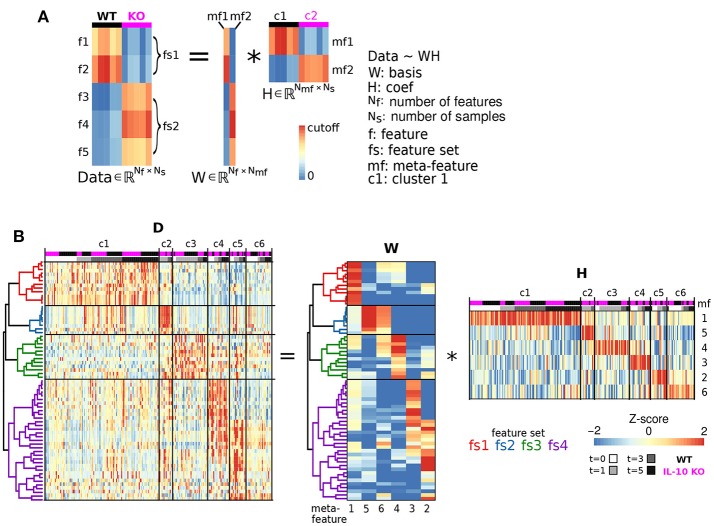
Morphological cell states characterized by distinct sets of morphological features. (A) Illustrative example of Non-negative matrix factorization (NMF) to show representations of a Data matrix, Basis matrix, and Coefficient matrix. (B) Microglial morphology data set organized according to feature sets. The Z-score matrix of morphological data D is organized based on the NMF analysis. The Basis matrix W of morphological meta-features is defined by four sets of features (fs1-4) from 218 reconstructed microglia, and the Coefficient matrix H shows a representation of meta-features in clusters of microglia (c1-6). *Denotes multiplication.